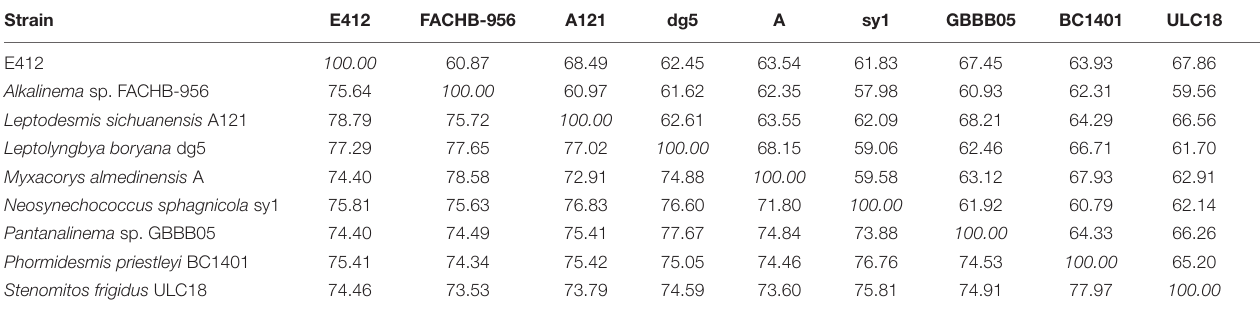
TABLE 2 | Values of ANI (Average Nucleotide Identity) and AAI (Average Amino acid Identity) among Leptolyngbyaceae genomes